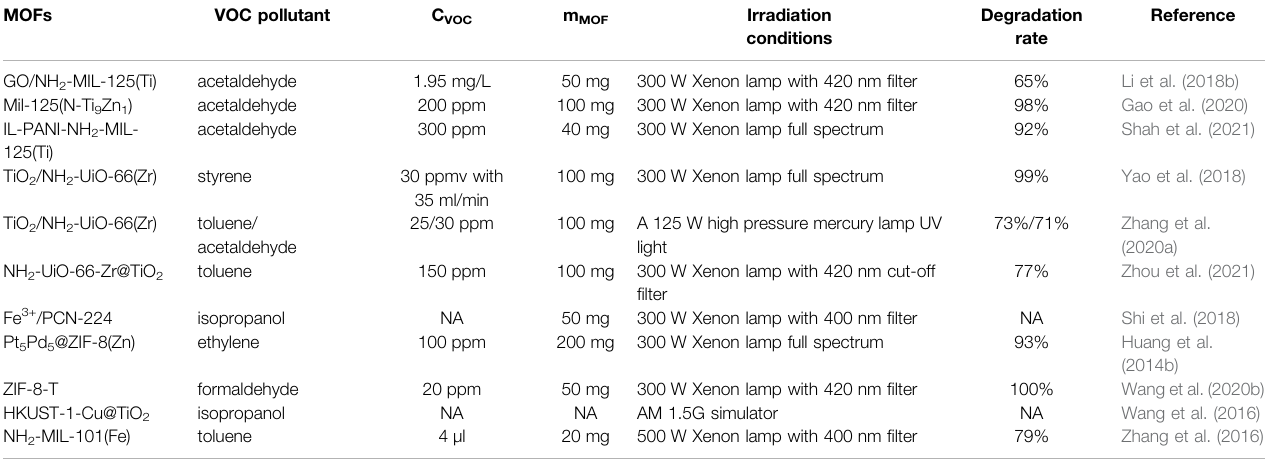
TABLE 1 | Current state-of-the-art MOFs photocatalysts applied for VOCs degradation.